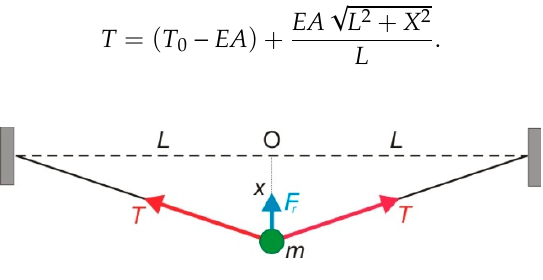
Figure 2. Force distribution in the strings.